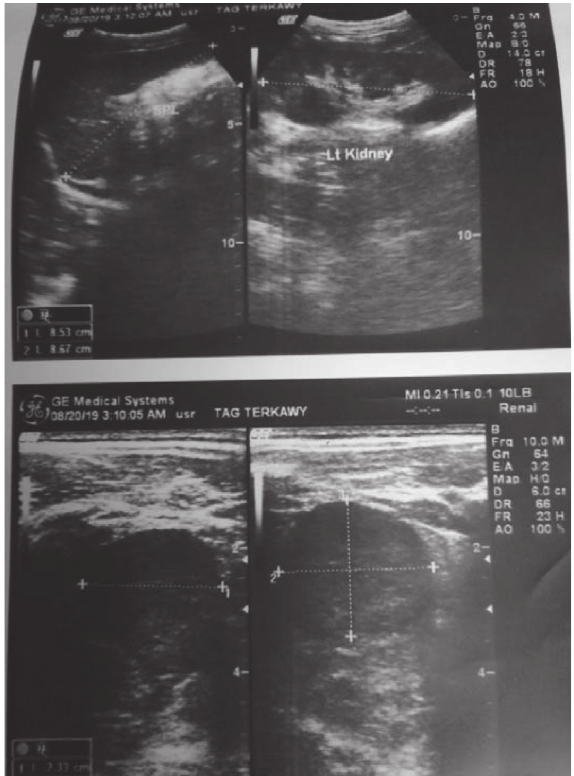
Figure 1: An abdominal ultrasound showed a well-defined rounded hypoechoic lesion with multiple tiny calcifications in the left suprarenal region measured 37 × 27 ×